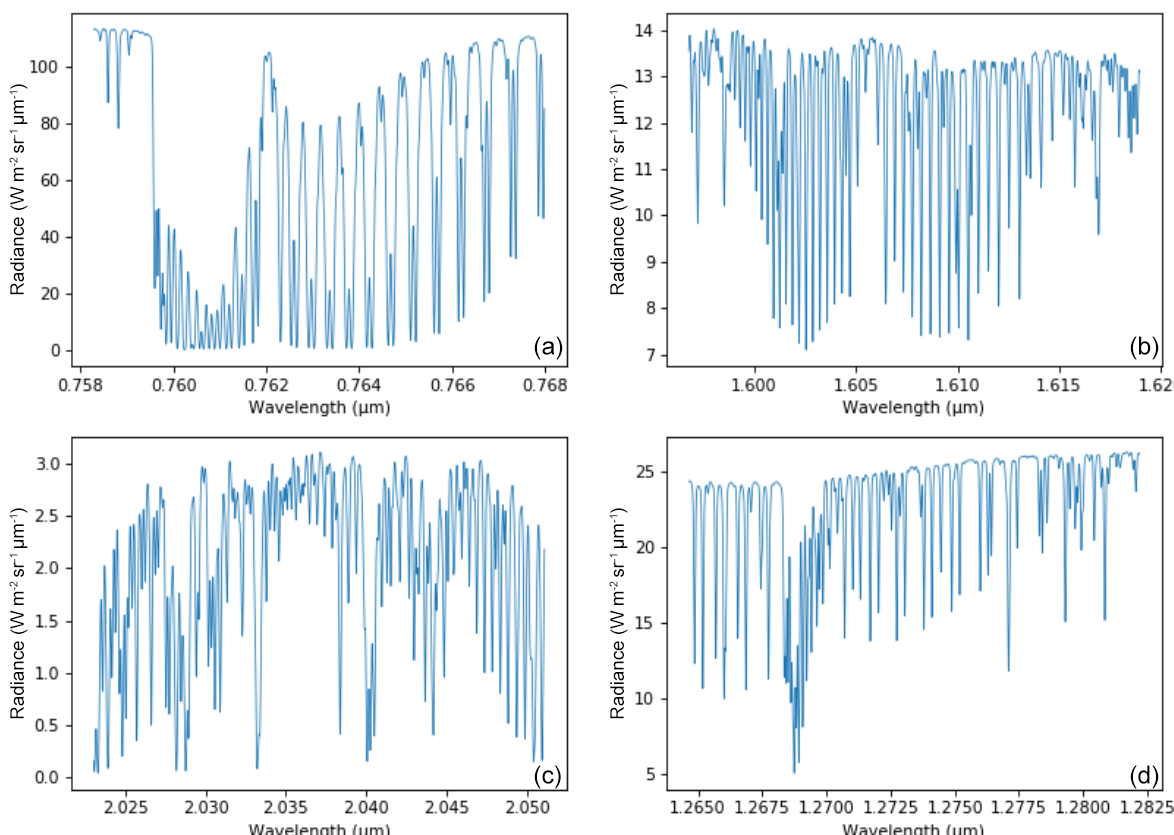
Figure 14. Example of MicroCarb simulated spectra of the strong O 2 band (B1) (a) , the weak O 2 band (B2) (b) , the strong O 2 band (B3) (c) , and the weak O 2 band (B4) (d)